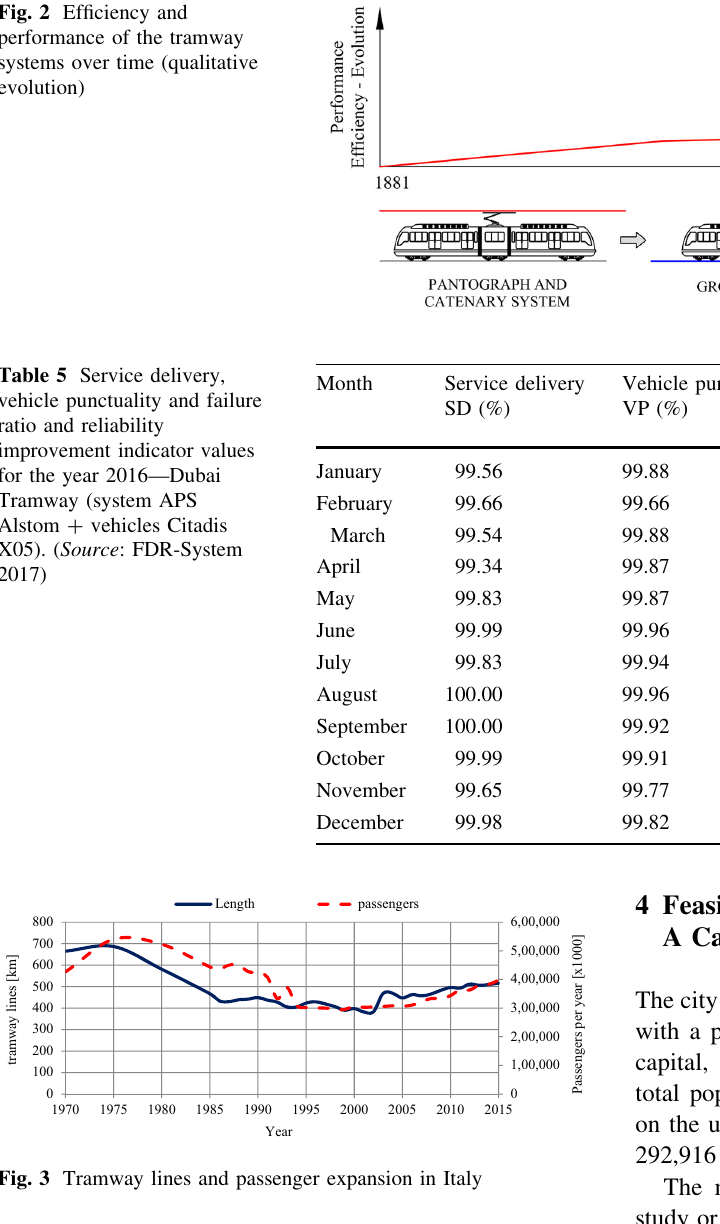
Fig. 2 Efficiency and performance of the tramway systems over time (qualitative evolution)